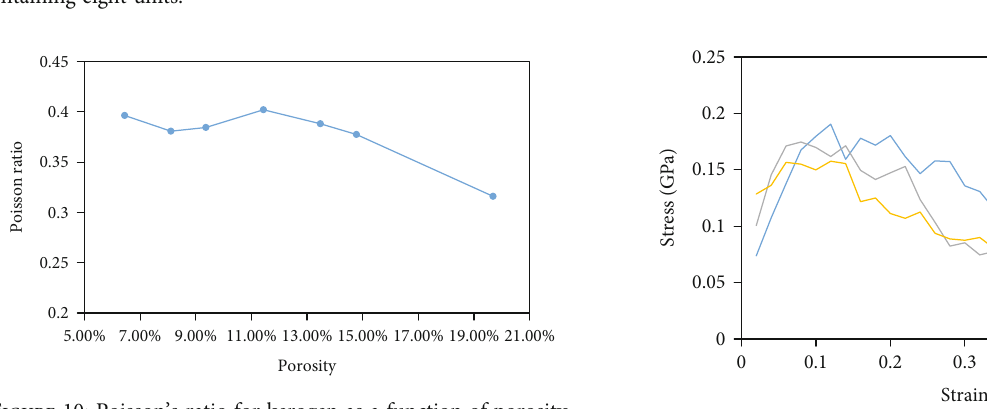
Figure 10: Poisson ’ s ratio for kerogen as a function of porosity.